Question: Give a one-sentence summary of this figure.
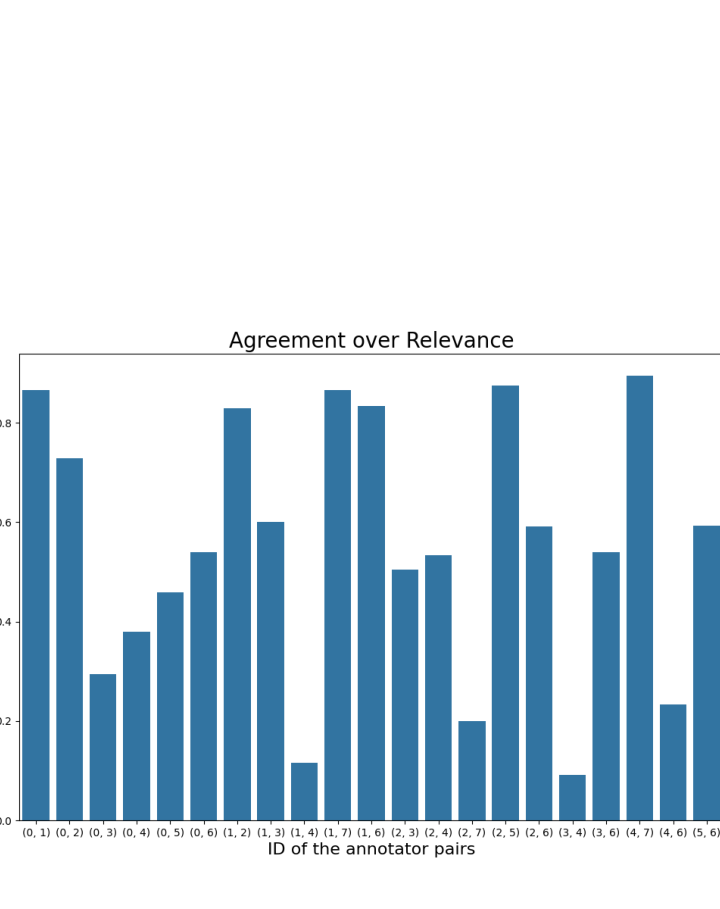
Answer: Annotator Agreement over the Relevance of a given reasoning step